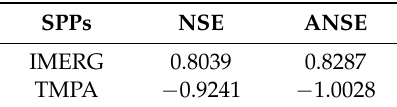
Table 4. Comparison between integrated multi-satellite retrievals for global precipitation measurement (IMERG) and tropical multi-satellite precipitation analysis (TMPA) performance on discharge